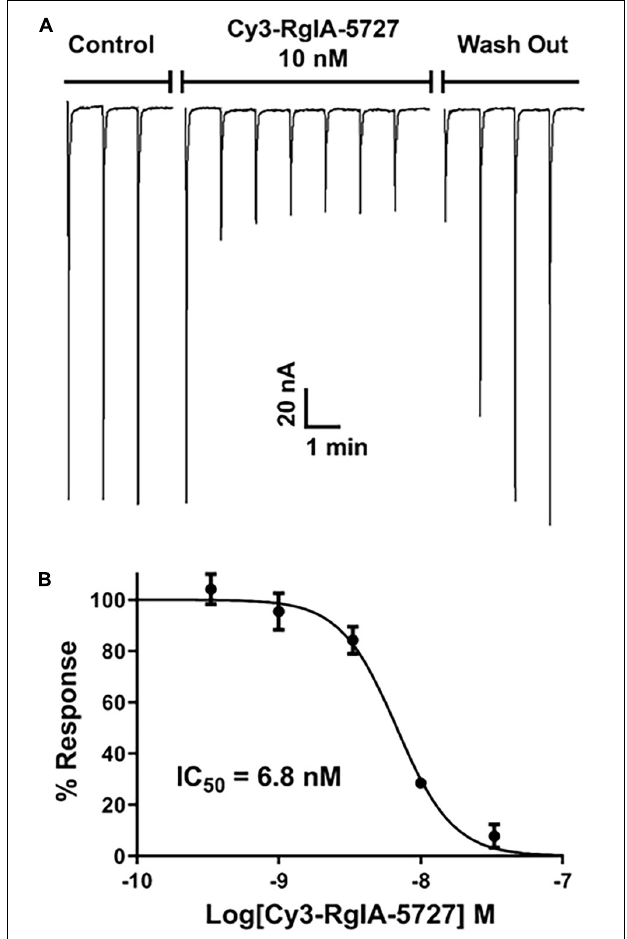
FIGURE 3 | Block and recovery from block of α 7 nAChRs by Cy3 RgIA-5727. (A) Cy3-RgIA-5727 (10 nM) was perfusion applied to Xenopus laevis oocytes expressing mouse α 7 nAChRs. Note the rapid recovery from block after removal of peptide. (B) Concentration response analysis indicated an IC 50 of 6.8 nM (see Table 1 ).